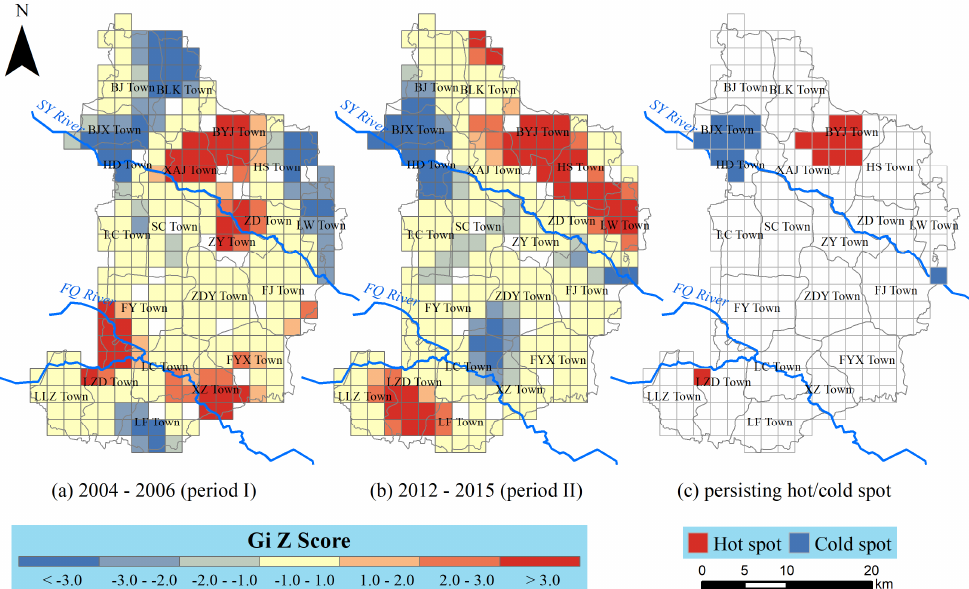
Figure 5. Result of hot spot analysis in terms of Gi Z score. ( a ) Hot/cold spot in Period I; ( b ) hot/cold spot in period II; ( c ) hot/cold spot both in Period I and Period II.